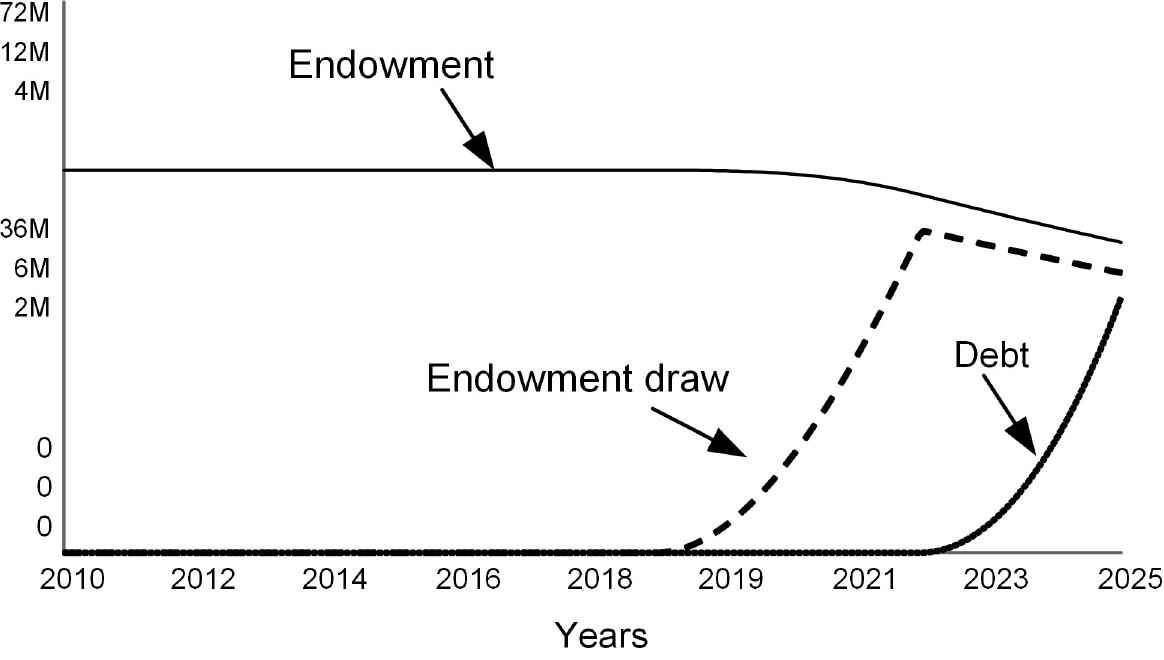
Fig 11. Endowment and